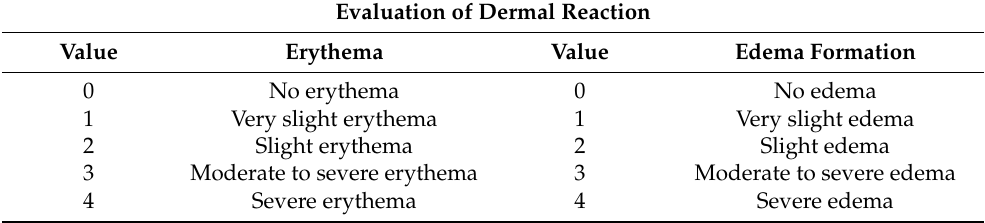
Table 13. Draize scoring for skin irritation.